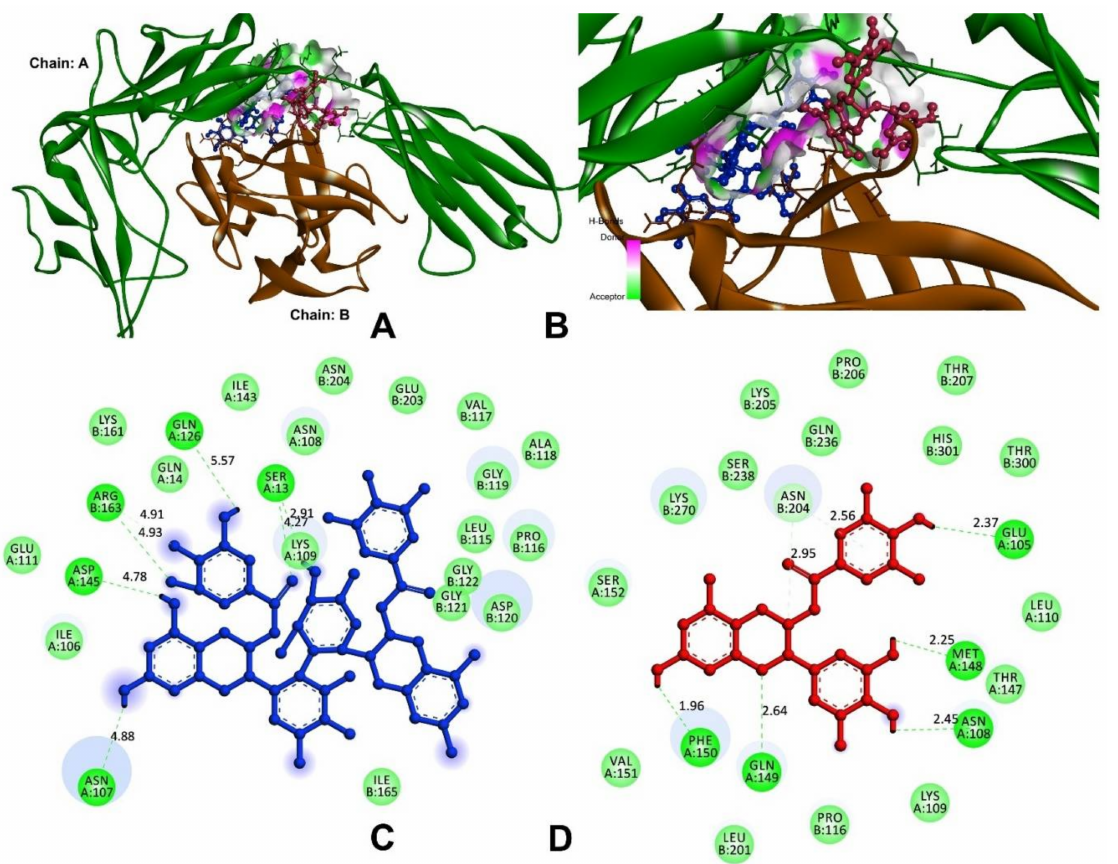
Figure 8. Molecular docking and interactions of IL-1 with theasinensin A and epigallocatechin gallate. ( A ) Chain-A ( green ) and chain-B ( brown ) of IL-1 bound with compounds of theasinensin A ( blue ) and epigallocatechin ( red ). ( B ) higher magnification of theasinensin A ( blue ) and epigallo- catechin gallate ( red ). ( C ) Molecular interactions of IL-1 and theasinensin A ( blue ). ( D ) Molecular interactions of IL-1 and epigallocatechin ( red